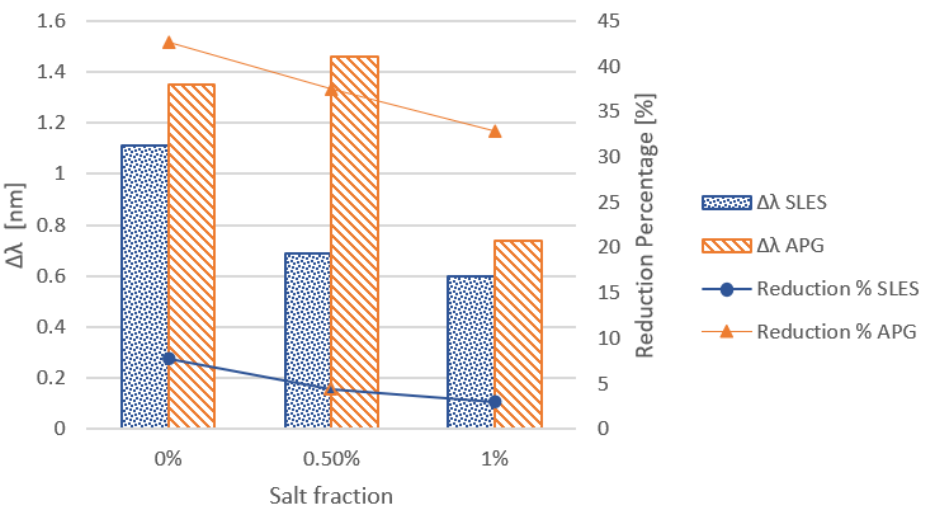
Figure 12. Correlation between the deposition and wet combing reduction percentage for samples with different levels of salt, formulated with both SLES/CAPB and APG/CAPB at 12 wt. % and cationic polymer 0.5 wt. % at room temperature and pH ~7.